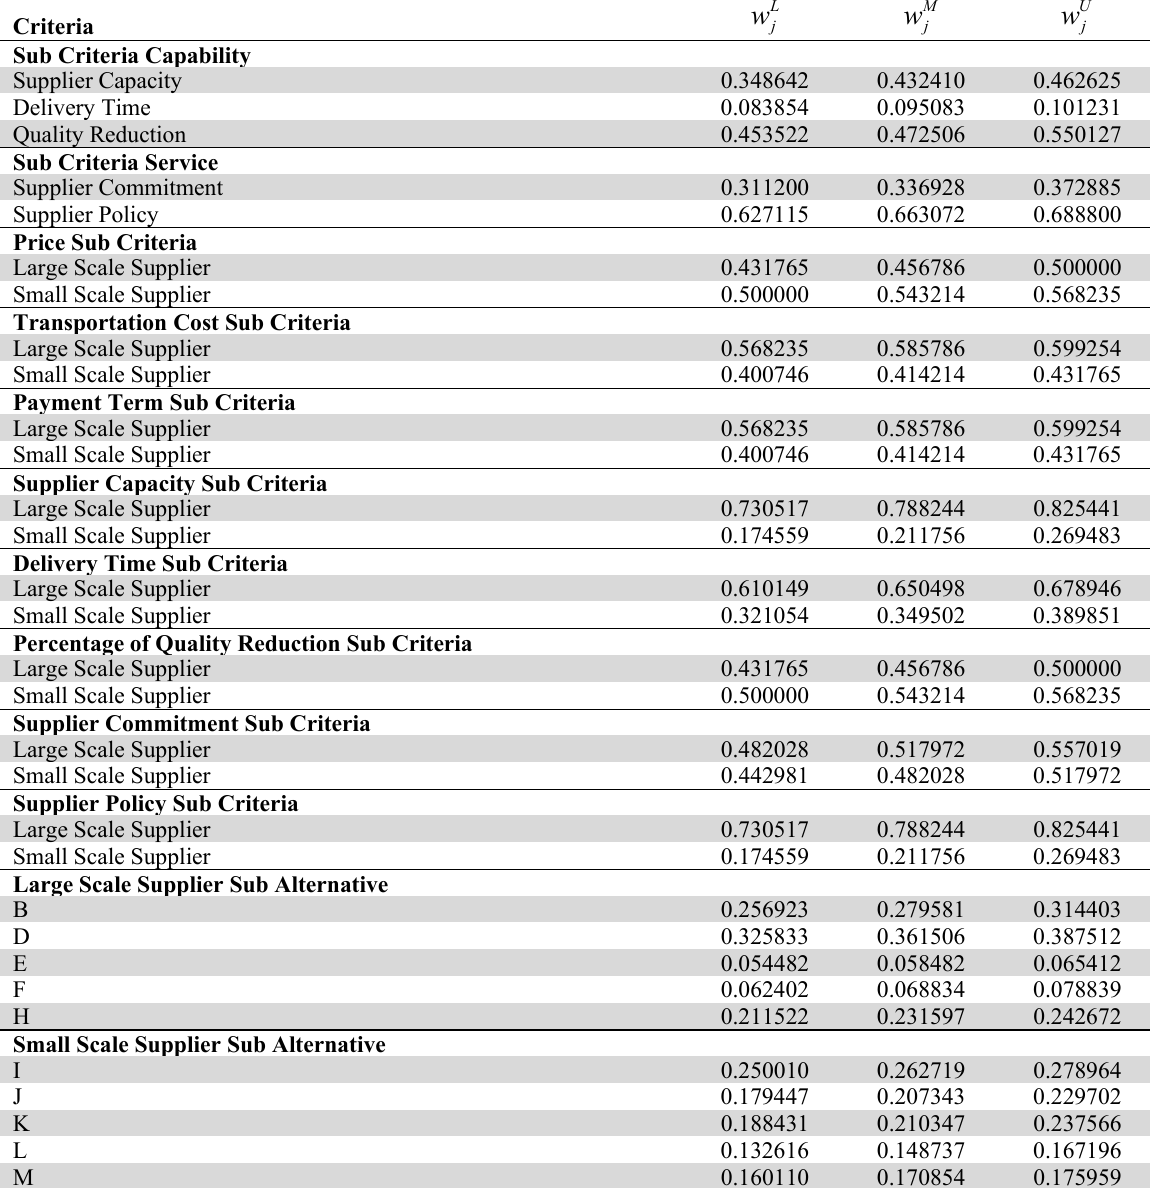
Priority Vectors Resulted by the Fuzzy LLSM Model (Continued) Criteria